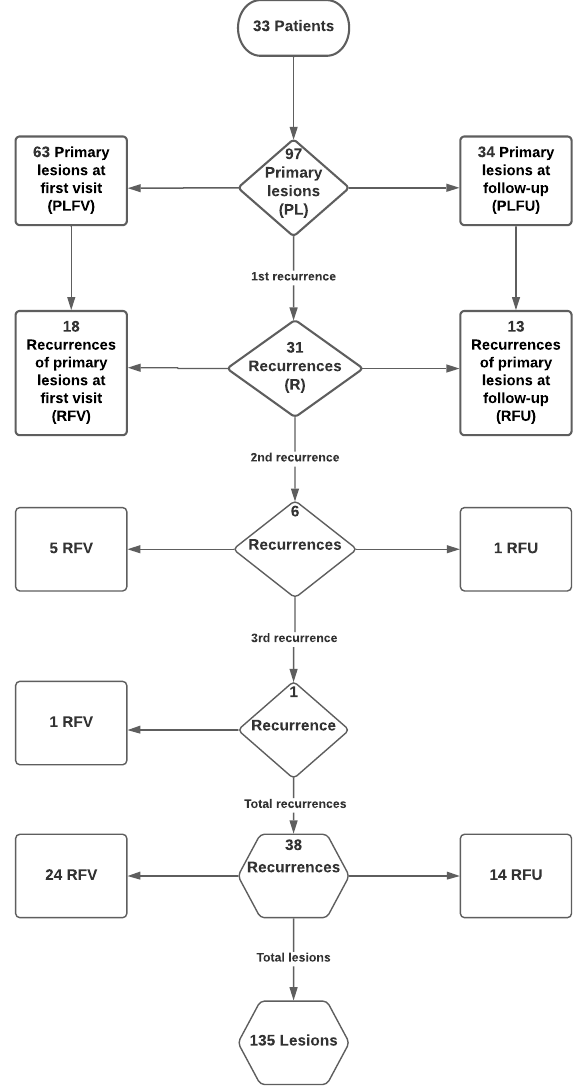
Figure 1. Flowchart of all 135 oral leukoplakia (OL) lesions, developing primary lesions (PLs) and recurrences (Rs), in all 33 patients.